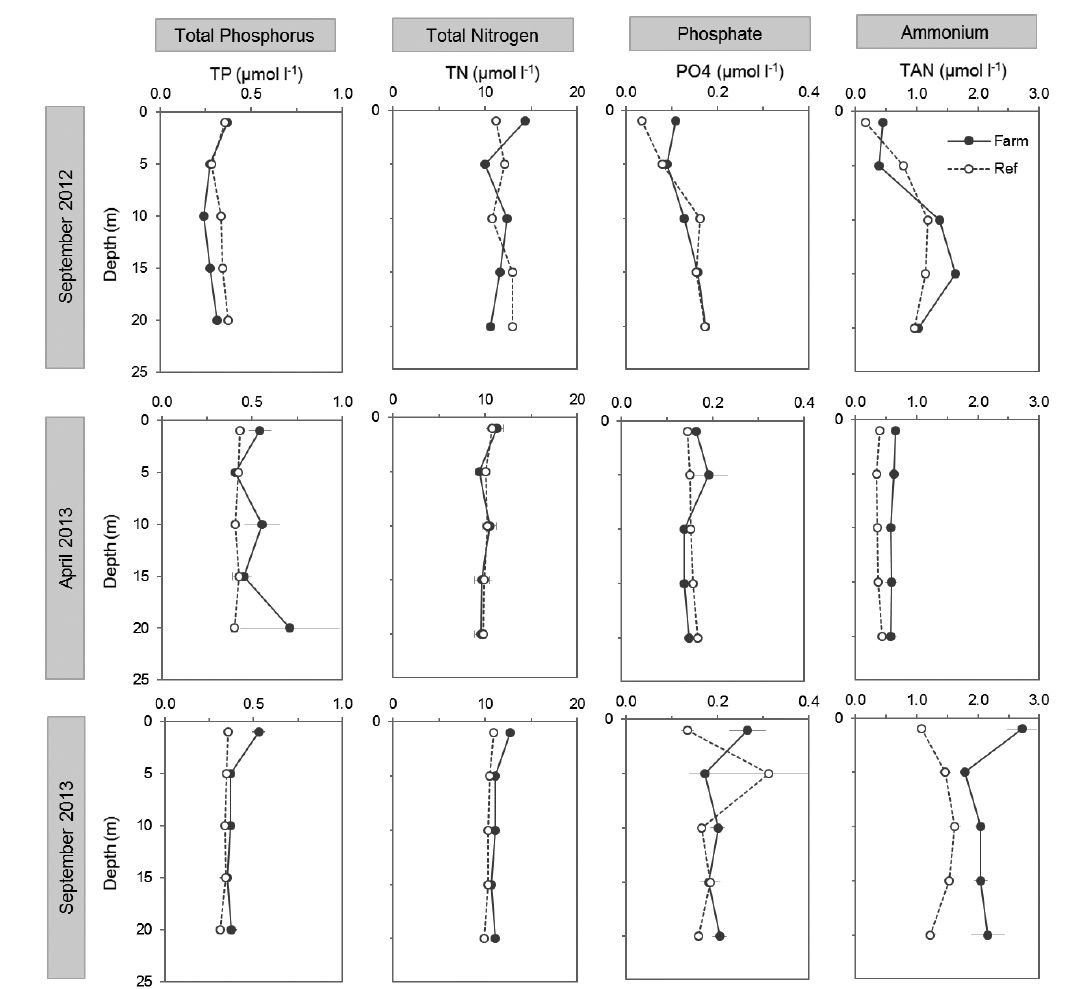
Fig. 4. Seasonal variability in nutrient concentrations at the farm (closed circles, Stns 2 and 3) and reference (open circles, Stns 15 and 16) locations. Values are presented as mean ± SE for April and September 2013 (n = 3 per station), and as averages excluding SE for September 2012 (n = 1 per station, see also Table